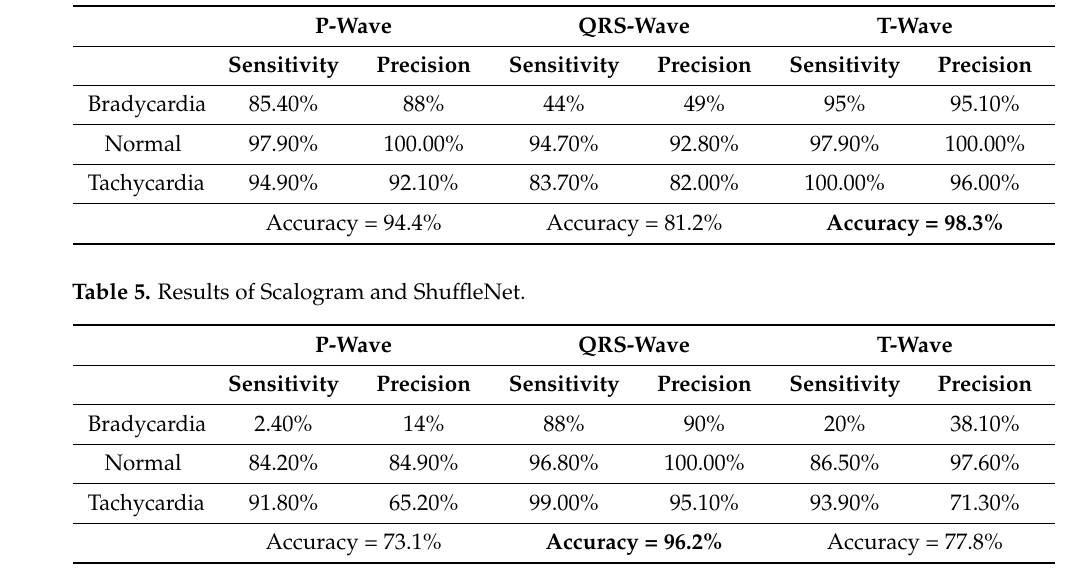
Table 4. Results of Scalogram and ResNet101.